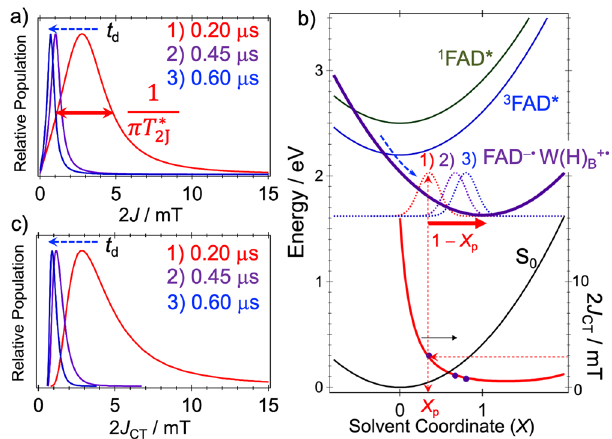
Fig. 4 Energetic disorder in the spin-spin exchange coupling. a Time ( t d ) dependent distributions of the S-T gap (2 J ) of the secondary CS state derived from the higher- fi eld curve (Supplemental Figure 9) of the E/A antiphase EPR line-shape for 1) t d = 0.20, 2) 0.45, and 3) 0.60 μ s at 120 K from the right to left, respectively. b Potential energy surfaces of the excited singlet state ( 1 FAD*), the triplet state ( 3 FAD*), the secondary CS state (FAD − (cid:129) ···W B (H) + (cid:129) ) and the ground state (S 0 ). The CS state energy distributions are caused by solvent dynamics, as represented by the Gaussian functions at 1) t d = 0.20, 2) 0.45, and 3) 0.60 μ s shown by the dotted lines. The computed S – T gap ( = 2 J CT ) from the con fi guration interaction model of Eq. (1) is plotted by the solid red line. c The population distributions (dotted lines in b) are plotted as the function of the 2 J CT (red line in b) for t d = 0.20, 0.45, and 0.60 μ s from the right to left, respectively.